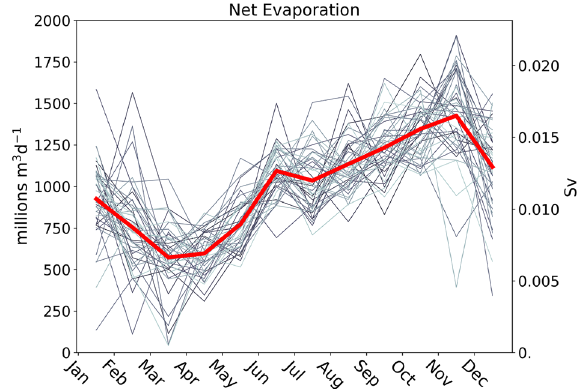
Figure 3. Monthly averaged net evaporation (evaporation minus precipitation) fluxes over the Gulf. The thick red line is the average over the time interval 1979–2021. The thin gray lines refer to the individual years (darker color corresponds to older year). The left axis reports the flux in millions of cubic meters per day, the right axis reports the same flux in Sverdrup (1 Sv = one million cubic meters per second). Data from the ERA5 reanalysis.